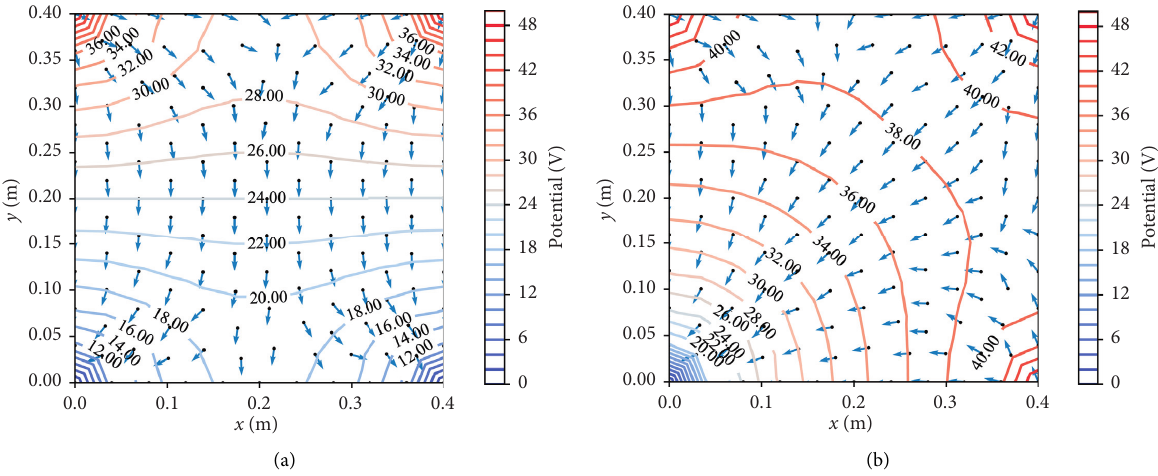
Figure 10: Gradient vector illustration of electric potential field. (a) Potential distribution of the symmetrical unit. (b) Potential distribution of the asymmetrical